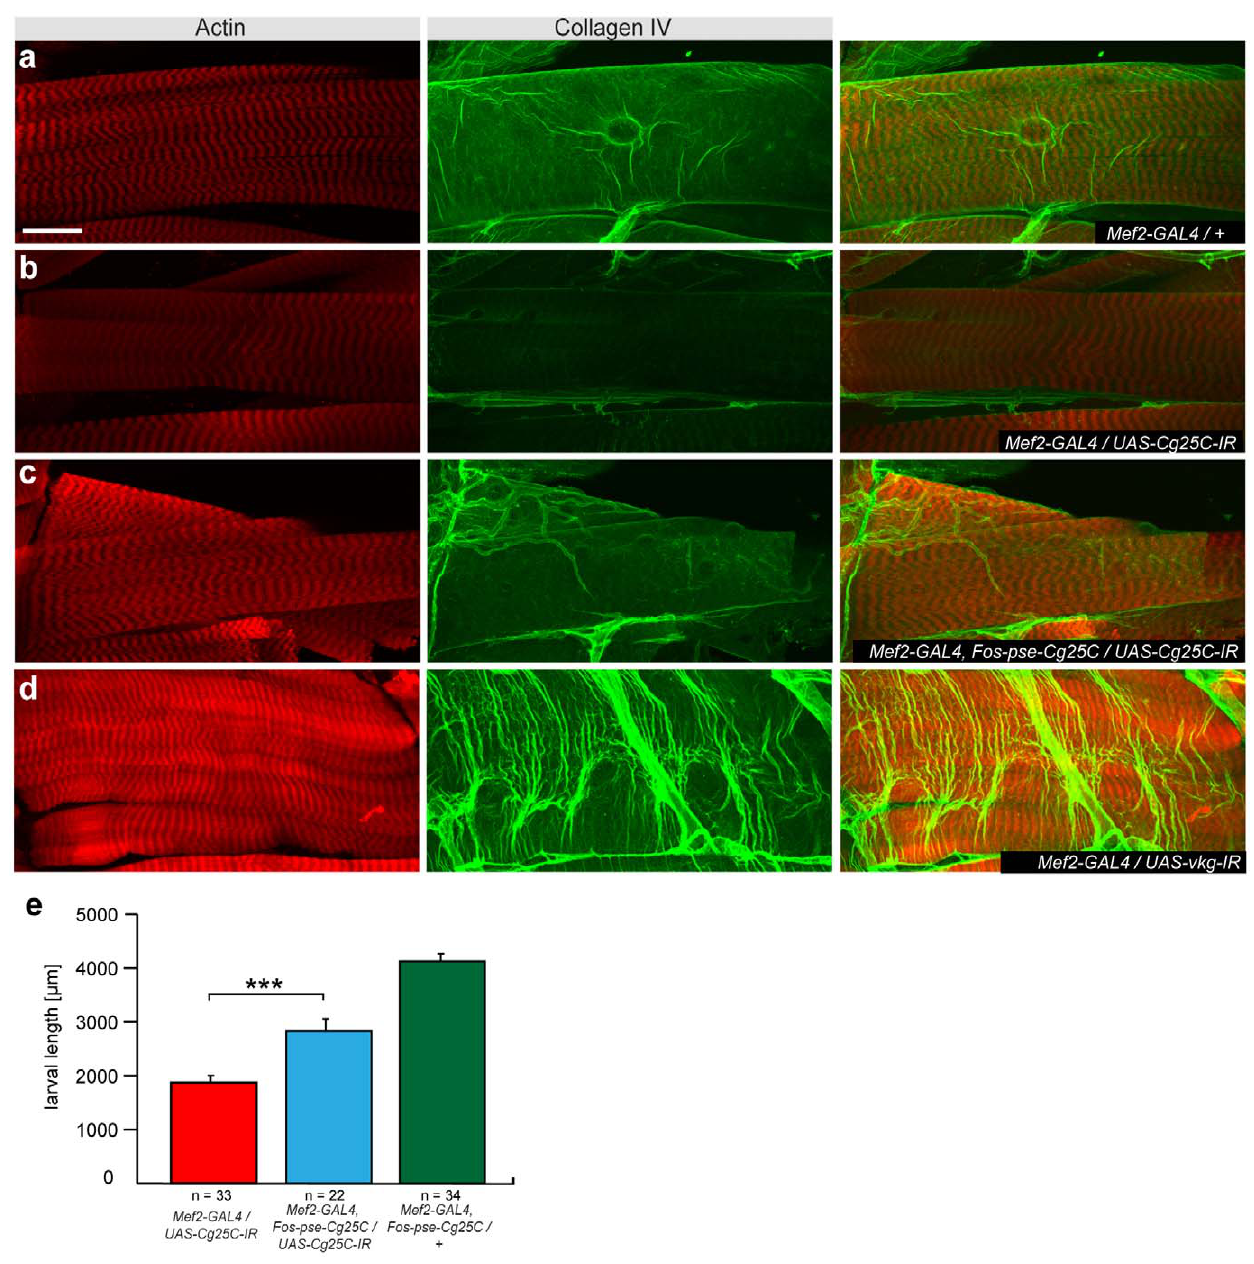
Figure 3. Rescue of Cg25C phenotype by D.pseudoobscura fosmid. ( a–d ) Collagen IV (green) wraps the larval muscles in wild type ( a ) and is strongly reduced in Mef2-GAL4/UAS-Cg25C-IR (TF104536) ( b ) but rescued by FlyFos-pse-Cg25C ( c ); Collagen IV levels are not altered in Mef2-GAL4/UAS- vkg-IR (TF106812) ( d ); actin is visualised with phalloidin; size bar corresponds to 25 m m. ( e ) Quantification of larval size in Mef2-GAL4/UAS-Cg25C-IR (TF104536) larvae (red) rescued by FlyFos-pse-Cg25C (blue) and wild type (green). ***p , 0.0001 (unpaired two-tailed t-test). 72–96 h after egg laying were assayed. Error bars indicate standard error of the mean (SEM).